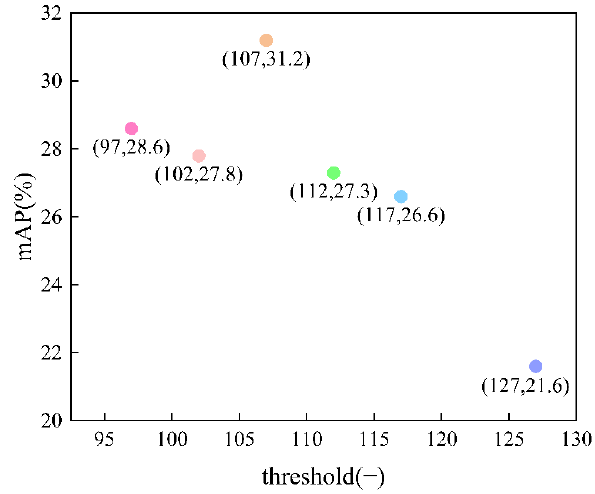
Figure 13. Variation of mAP of the model with threshold.